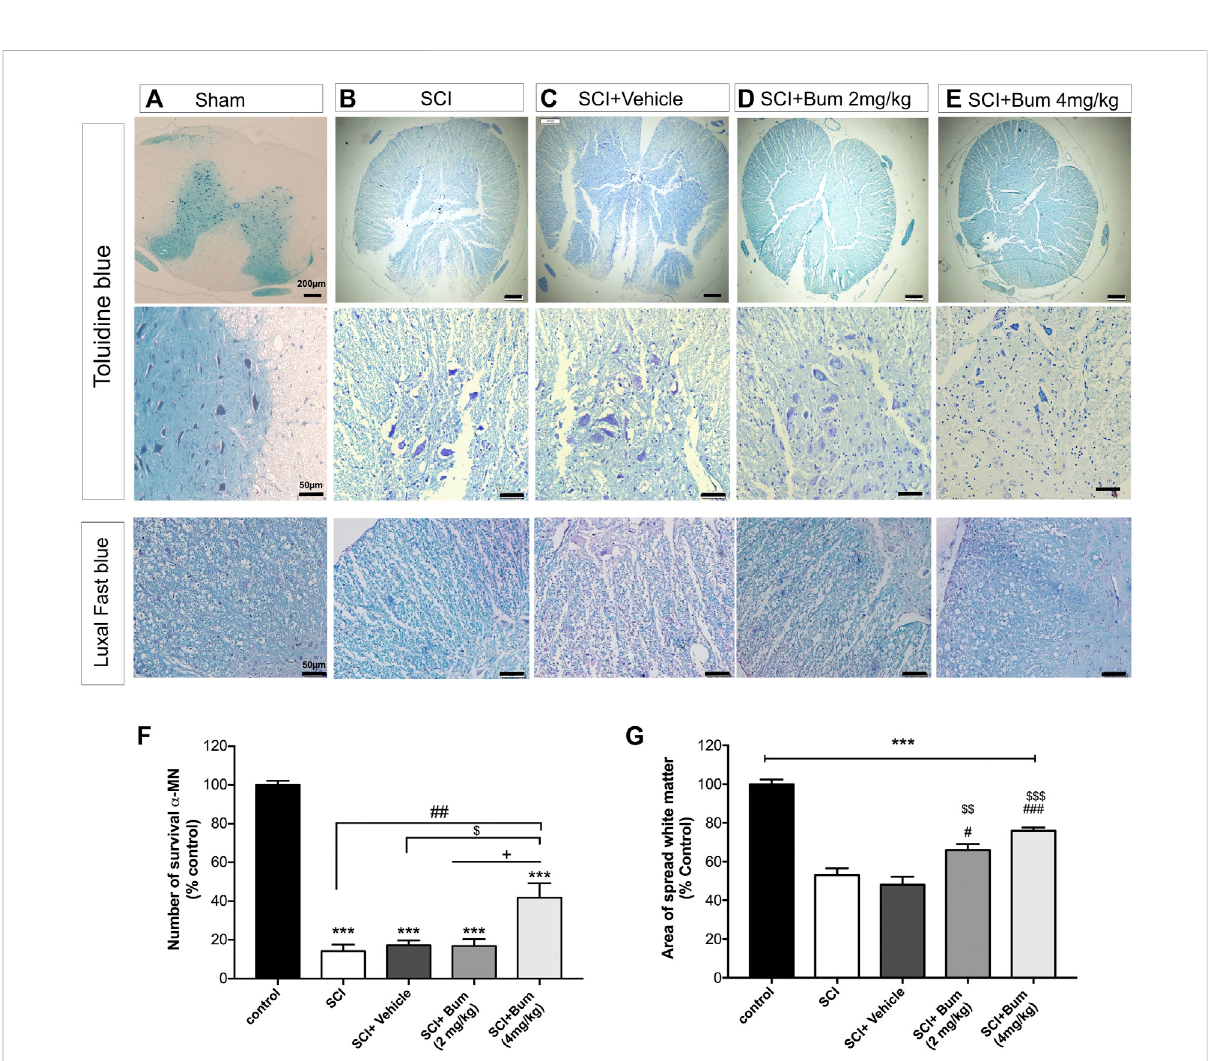
FIGURE 6 Toluidine blue staining for rats undergoing spinal cord injury (SCI) evaluated at 28 days post SCI (A – D) . Histopathologic features were investigatedathighmagni fi cation,regionofextensivedegeneration(redbox,panelb – c)withdemyelination(redarrows,panelsb – c),andin fi ltration (black arrow panel b). (F) Quantitative analysis for the number of motor neurons (% of sham group) among the groups was determined at 4 weeks after SCI. (G) Graph bar shows quantitative evaluation of spared white matter in LFB-stained sections. The bumetanide 4 mg/kg group showed more white matter than the SCI group. The data are shown as the mean ± SD. *** p ≤ 0.001 vs. control, # p ≤ 0.05, ## p ≤ 0.01, vs. the treated SCI group; $ p ≤ 0.05, $$ p ≤ 0.01, $$$ p ≤ 0.001 vs. the vehicle group; + p ≤ 0.05 vs. Bum 2 mg/kg group; scale bar = 50 μ